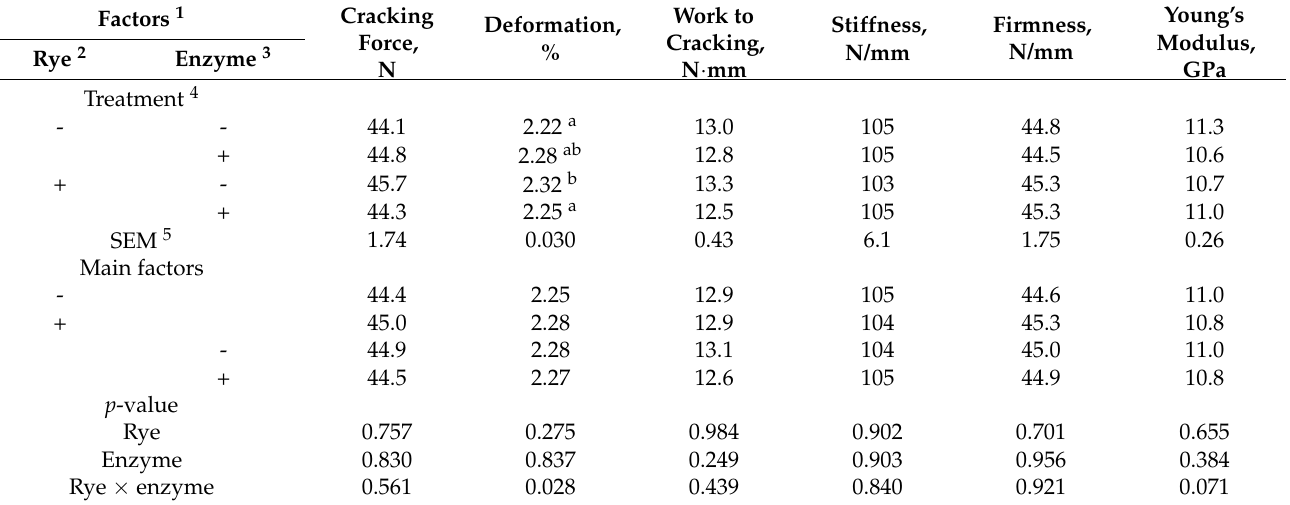
Table 5. Effect of 25% dietary rye inclusion and xylanase supplementation (200 mg/kg of feed) on eggshell mechanical properties at the end of the laying cycle–mechanical testing in the equatorial